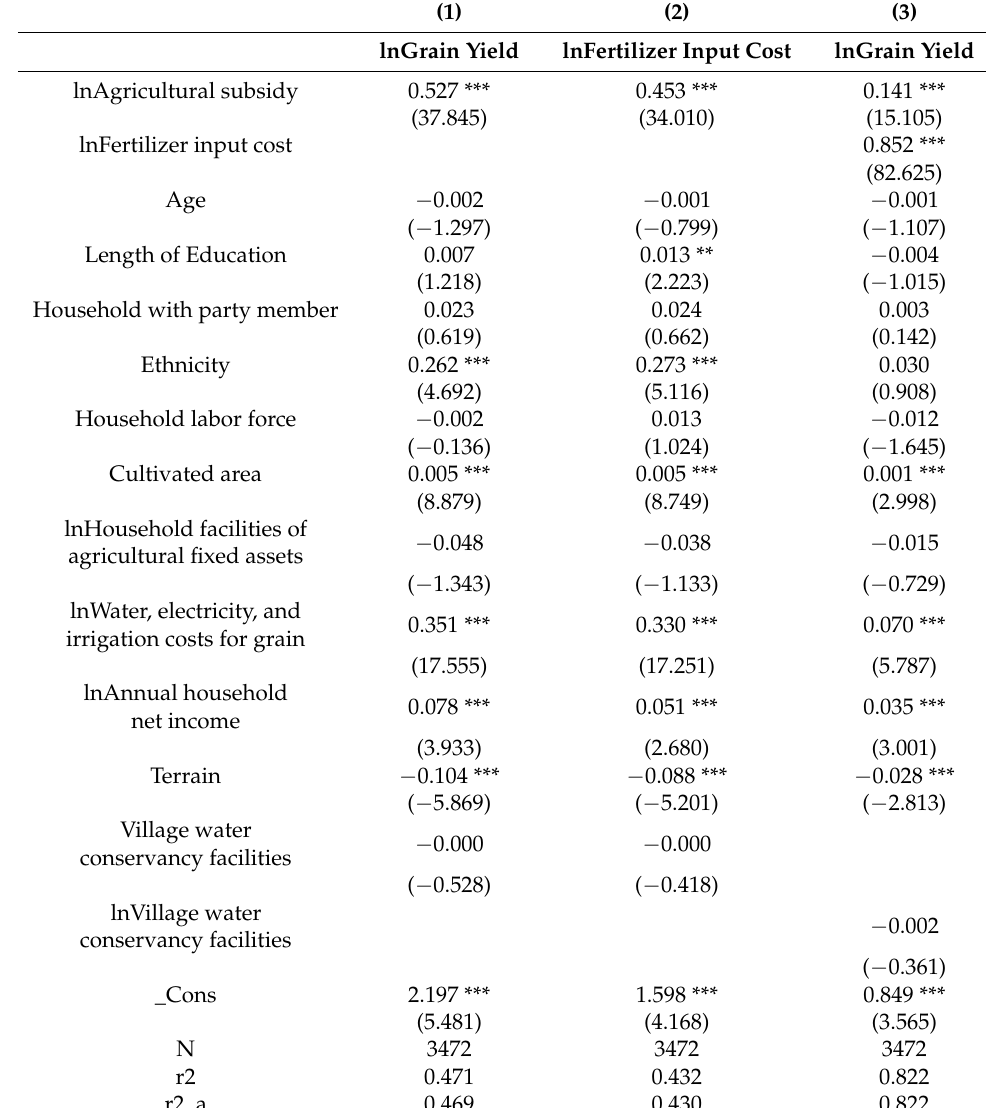
Table 5. Mediating effects of fertilizer